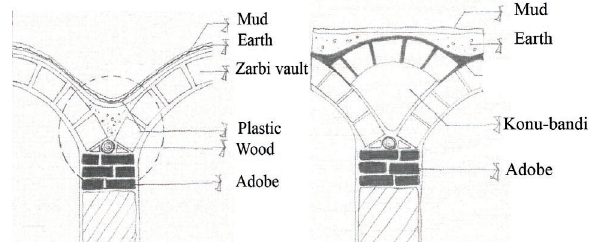
Figure 17. How does the Konu-bandi run?, author. 2.3 Roof of the houses in the fourth era; contemporary times